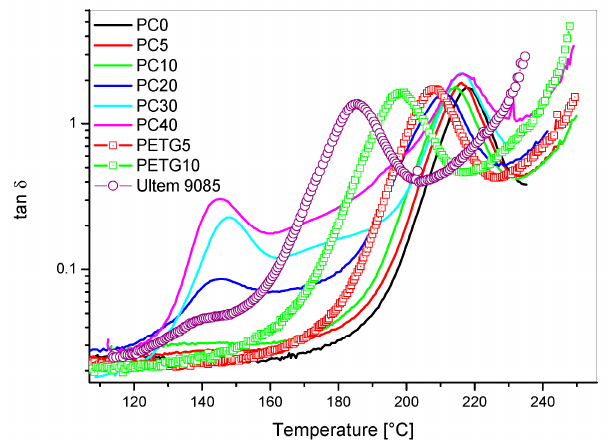
Figure 2. Tan δ versus temperature for PEI/PC and PEI/PETG blends compared to Ultem 9085: effect of PC and PETG content. Reprinted from [20] with permission from MDPI.